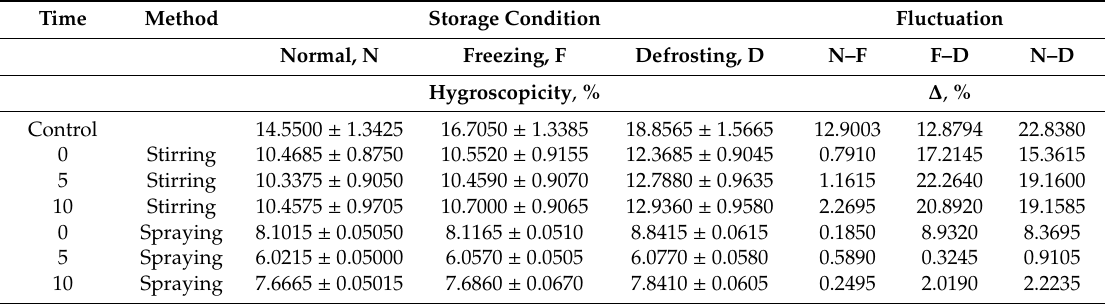
Table 6. Descriptive analysis for the hygroscopicity of fines of non-wood pellets with addition by stirring or spraying of liquid-state food waste subjected to the process of freezing–defrosting.